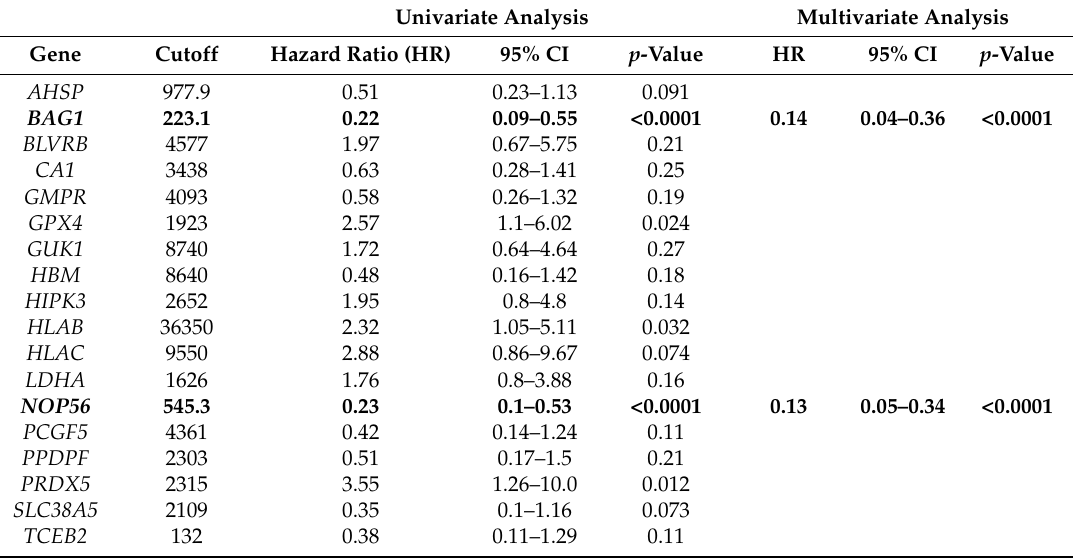
Table 2. The 18 genes in the VS were analyzed using Cutoff Finder to find the optimal cutoff for predicting OS. Genes that reach statistical significance ( p < 0.05) are